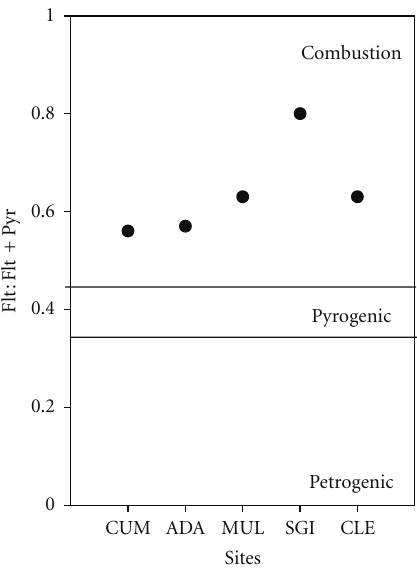
Figure 4: Ratios of Fluoranthene:Fluoranthene + Pyrene in soils and potential emission sources for the study catchments (Lough Cummeenoughter (CUM), Lough Adanacleveen (ADA), Mullincrick Lough (MUL), Sgilloge Lough (SGI), and Cleevaun Lough